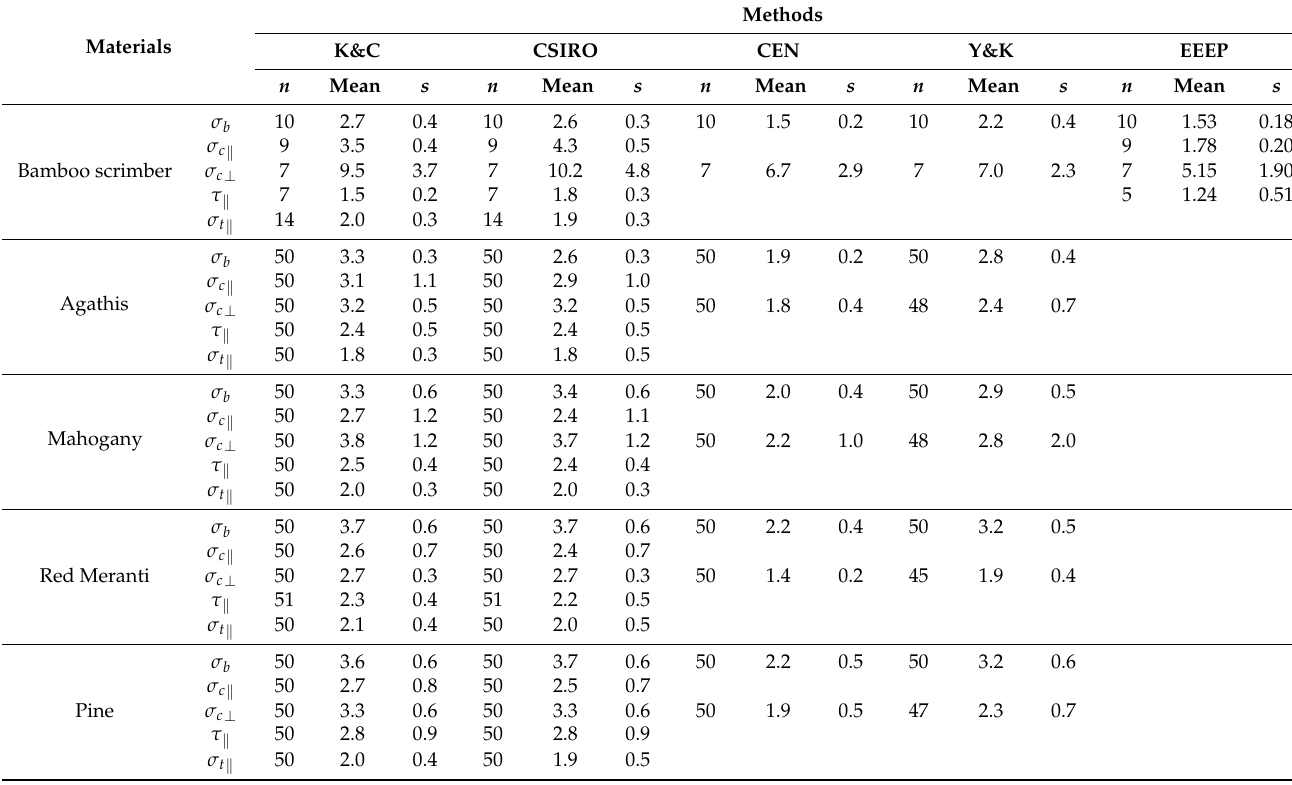
Table 4. Descriptive statistic of ductility ratio.